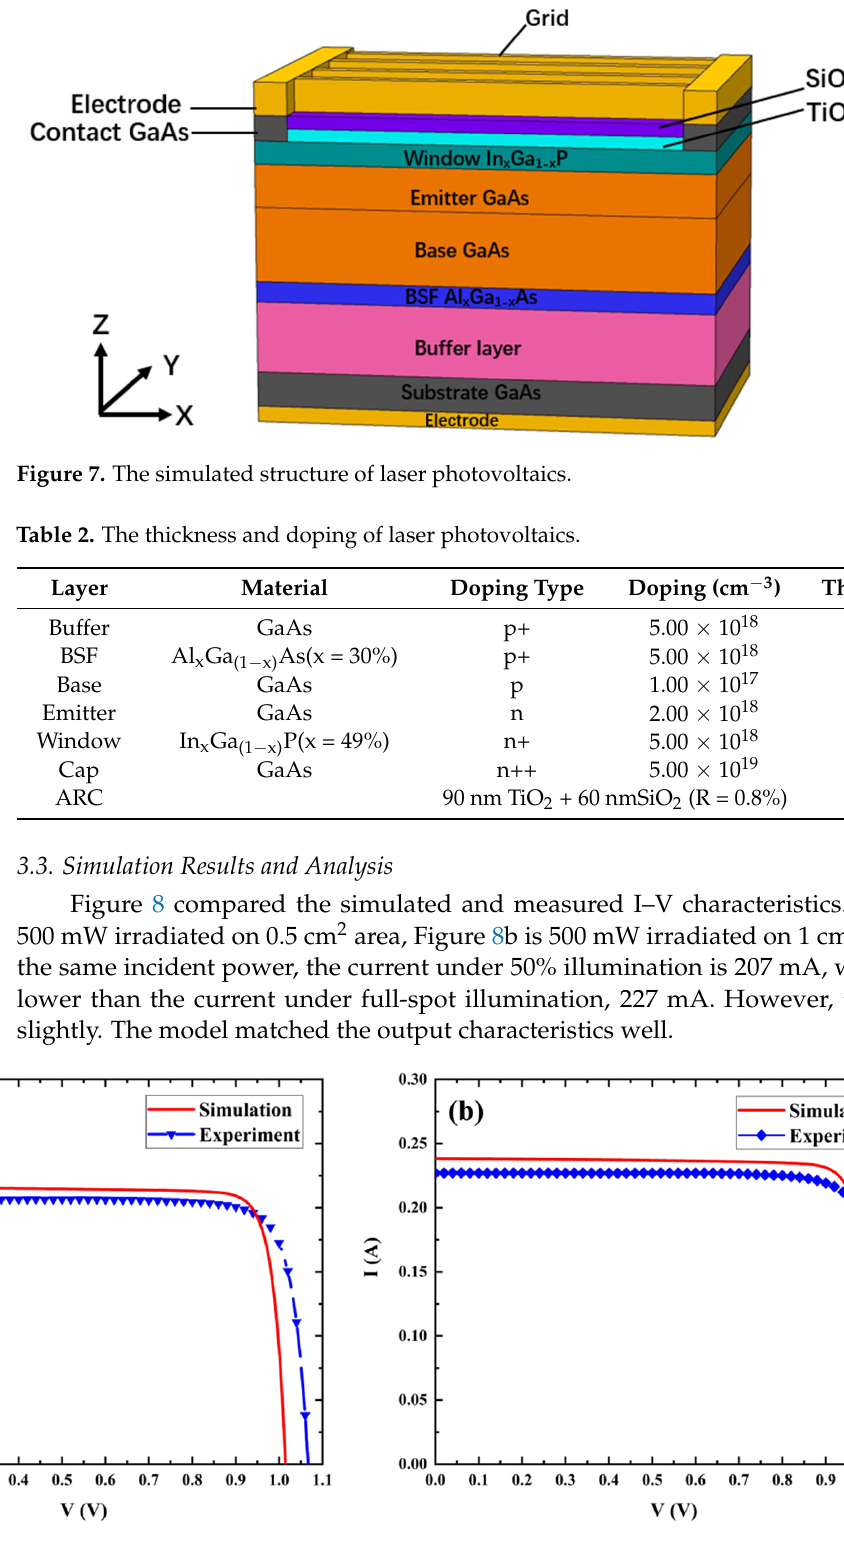
Figure 8. A simulation and experiment of I − V characteristics ( a ) under 50% illumination; ( b ) under full − spot illumination.